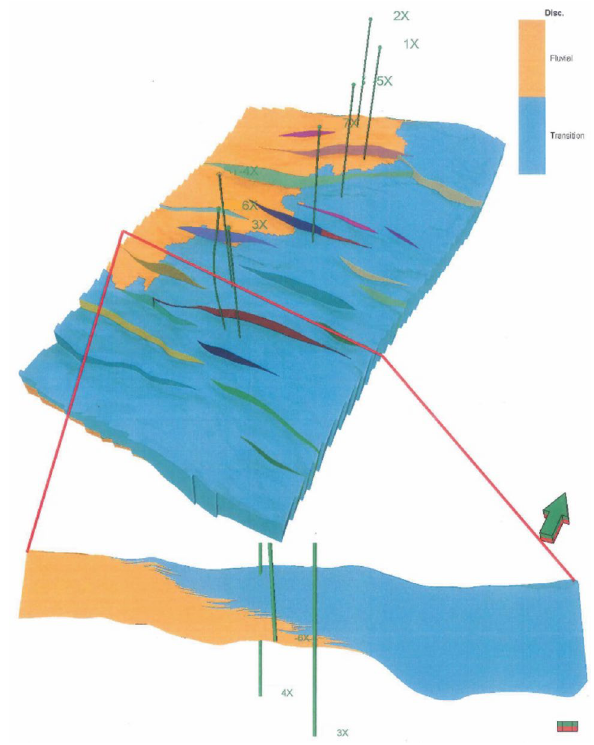
Fig. 22 Model in I and